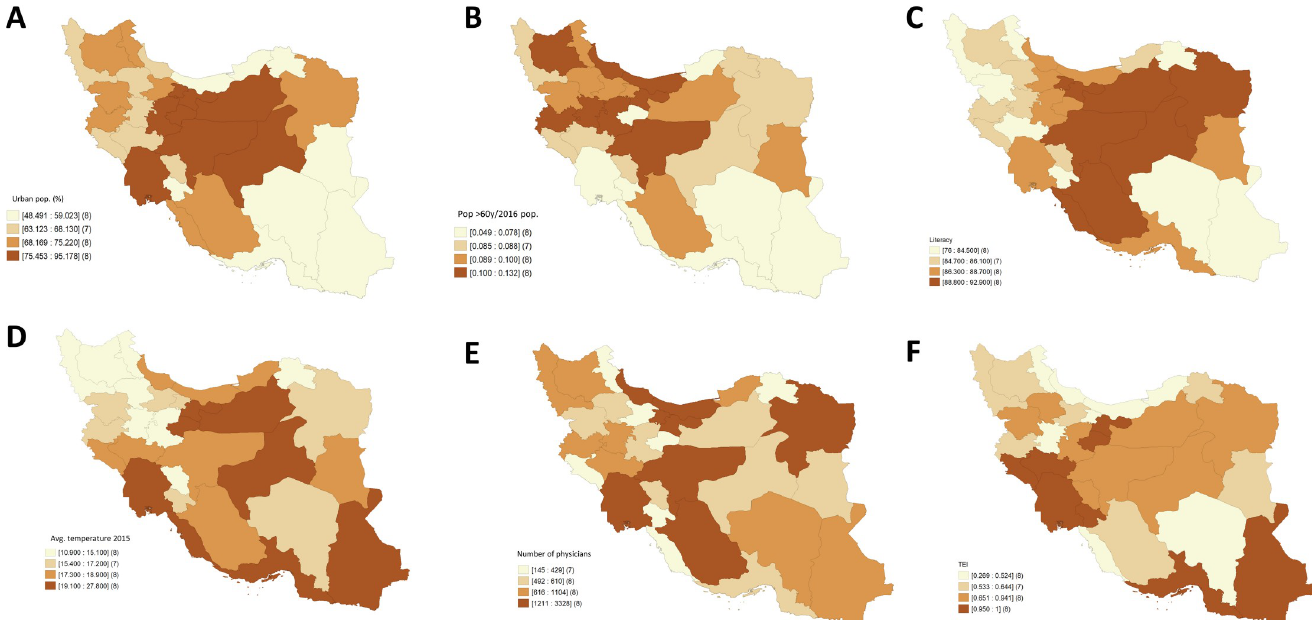
Fig 3. Quartiles associated with all the explanatory variables significant in the spatial lag model with response variable the logarithm of the number of COVID-19 cases. A) People settled in urban areas in 2016 (%). B) People aged � 60 years, rates obtained through empirical Bayes smoothing. C) Literacy of population aged � 6 years in 2016 (%). D) Average temperature (˚C) of provincial capitals in 2015. E) Number of physicians employed by the ministry of health and medical education in 2006. F) Transportation Efficiency Index (TEI). Shapefiles obtained from the Stanford Libraries Earthworks: https://earthworks.stanford.edu/